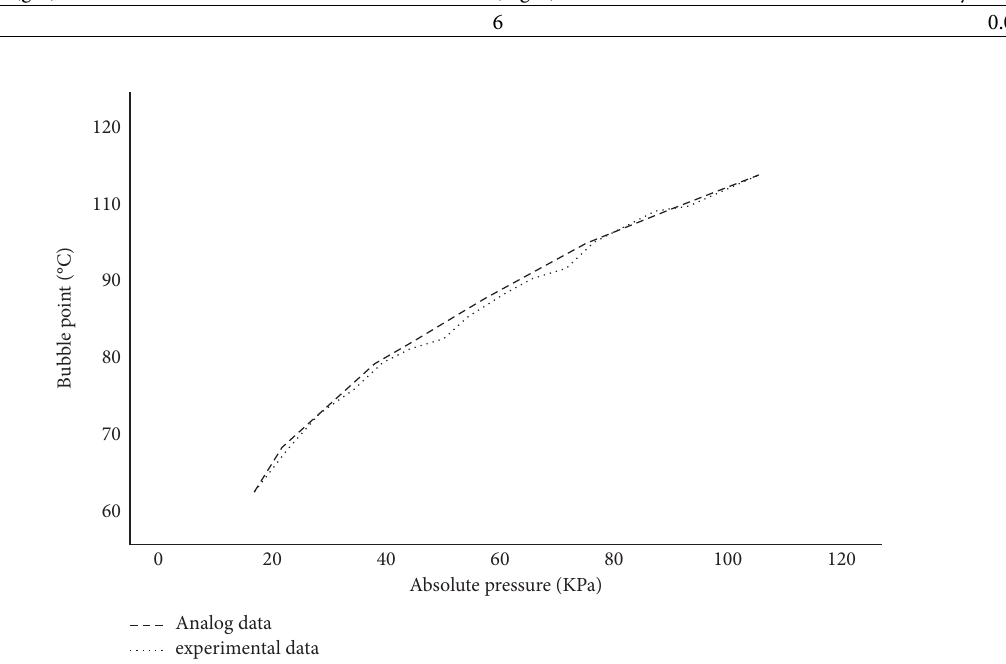
Figure 3: Brine system bubble simulated data compared with the experimental data. Table 2: Comparison of steam generation and discharge of different efficiency in the brine